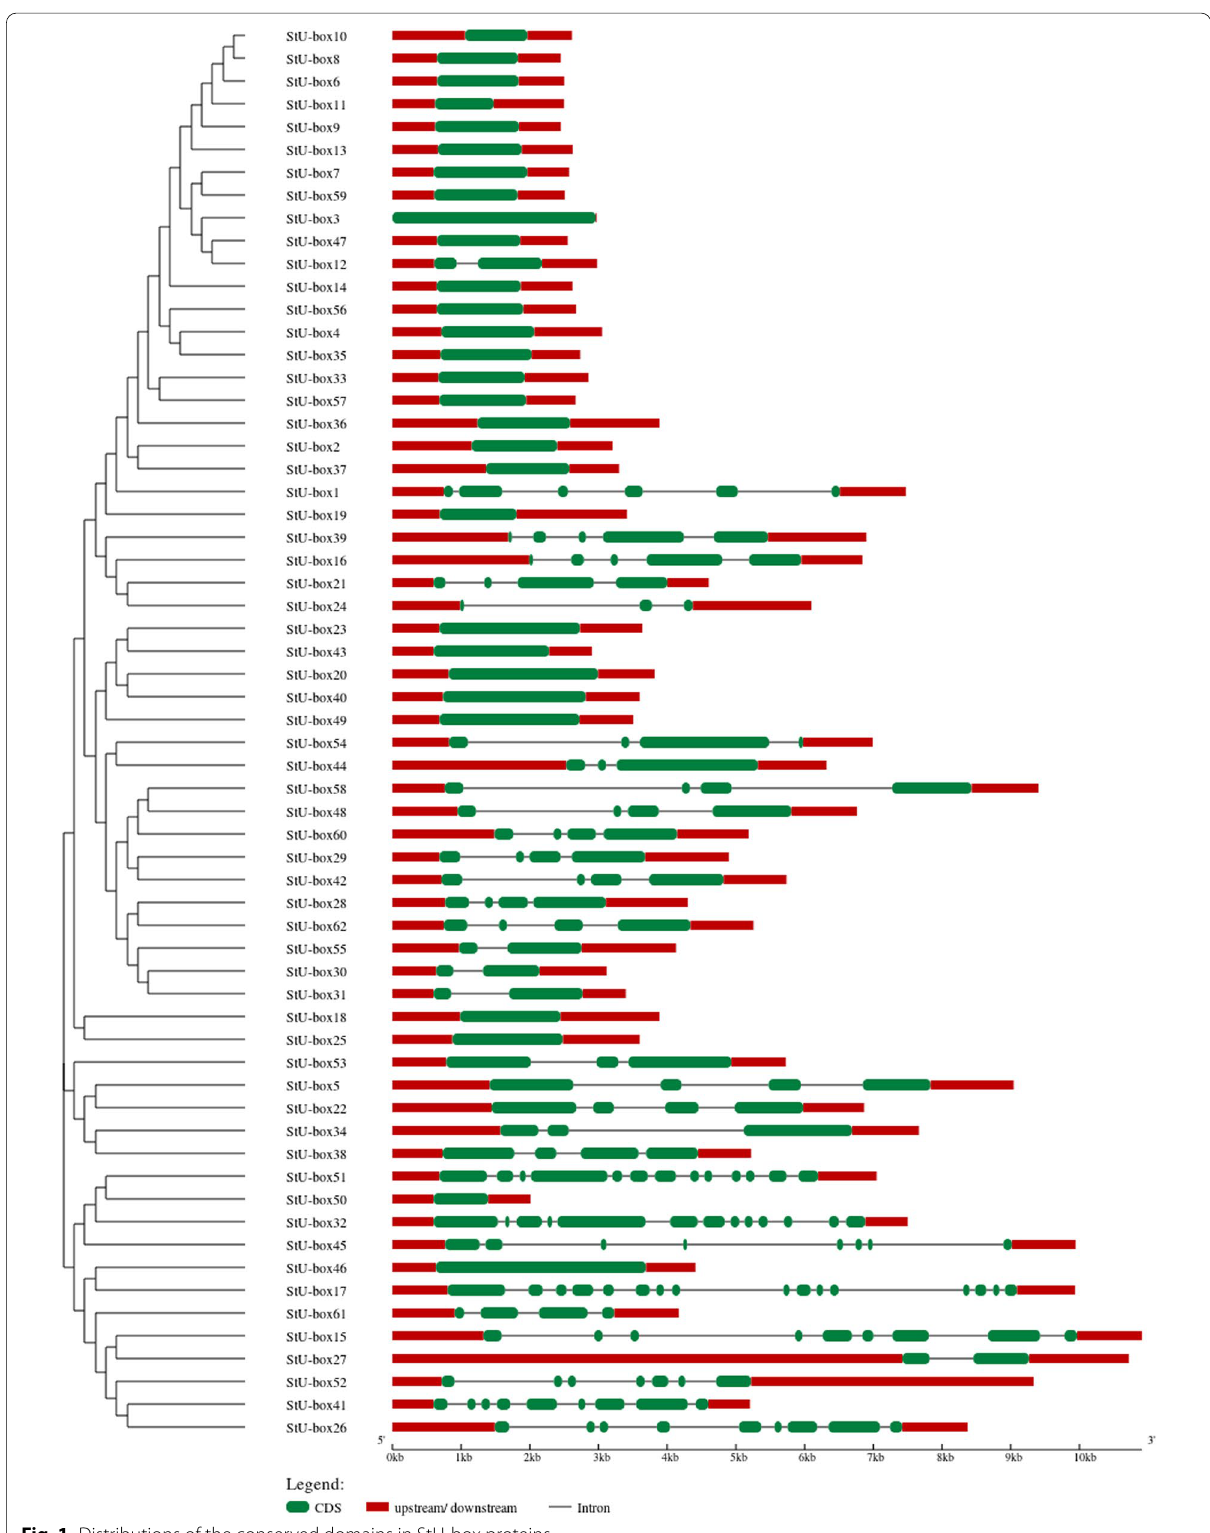
Fig. 1 Distributions of the conserved domains in StU-box